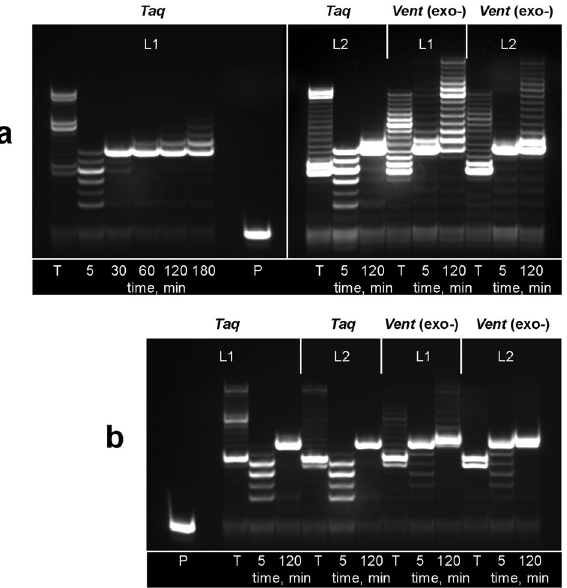
Figure 3. Electrophoretic separation of the labelled extension products formed in the PEX reaction with TTP/dU1 and templates L1/L2 in the absence ( a ) or presence ( b ) of the dATP, dCTP, and dGTP mixture. Lane T: TTP, 1 h. Lane P: primer. Lanes with time labels: dU1. Source gel images are presented in Supplementary Figure